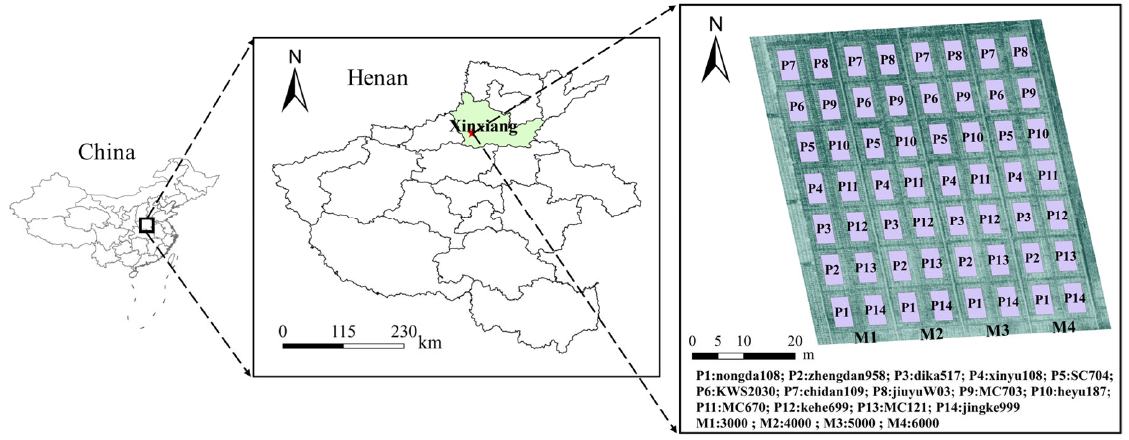
Figure 1. Study site and experiment plot. Note: P1–P14 represent different maize varieties, and M1–M4 represent different densities of 3000, 4000, 5000, and 6000 plants per mu (about 45,000, 60,000, 75,000, and 90,000 plants per hectare).